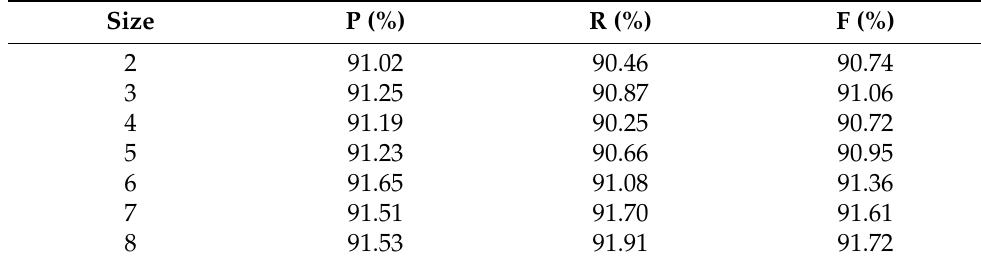
Table 5. Experimental results of different convolution kernel sizes.